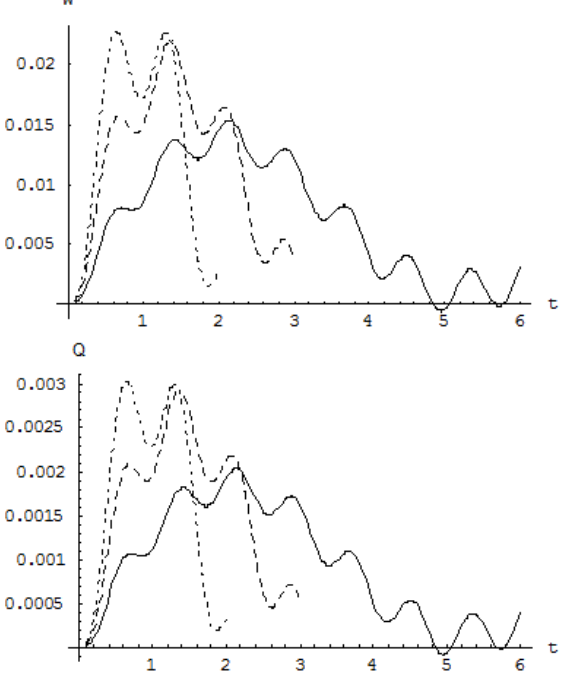
Figure 16: The influence of the vehicle’s speed for R = 150 m, e H = 3 m and υ = 10 m/s ( __ ), υ = 20 m/s ( _ _ ) and υ = 30 m/s (- - - ).